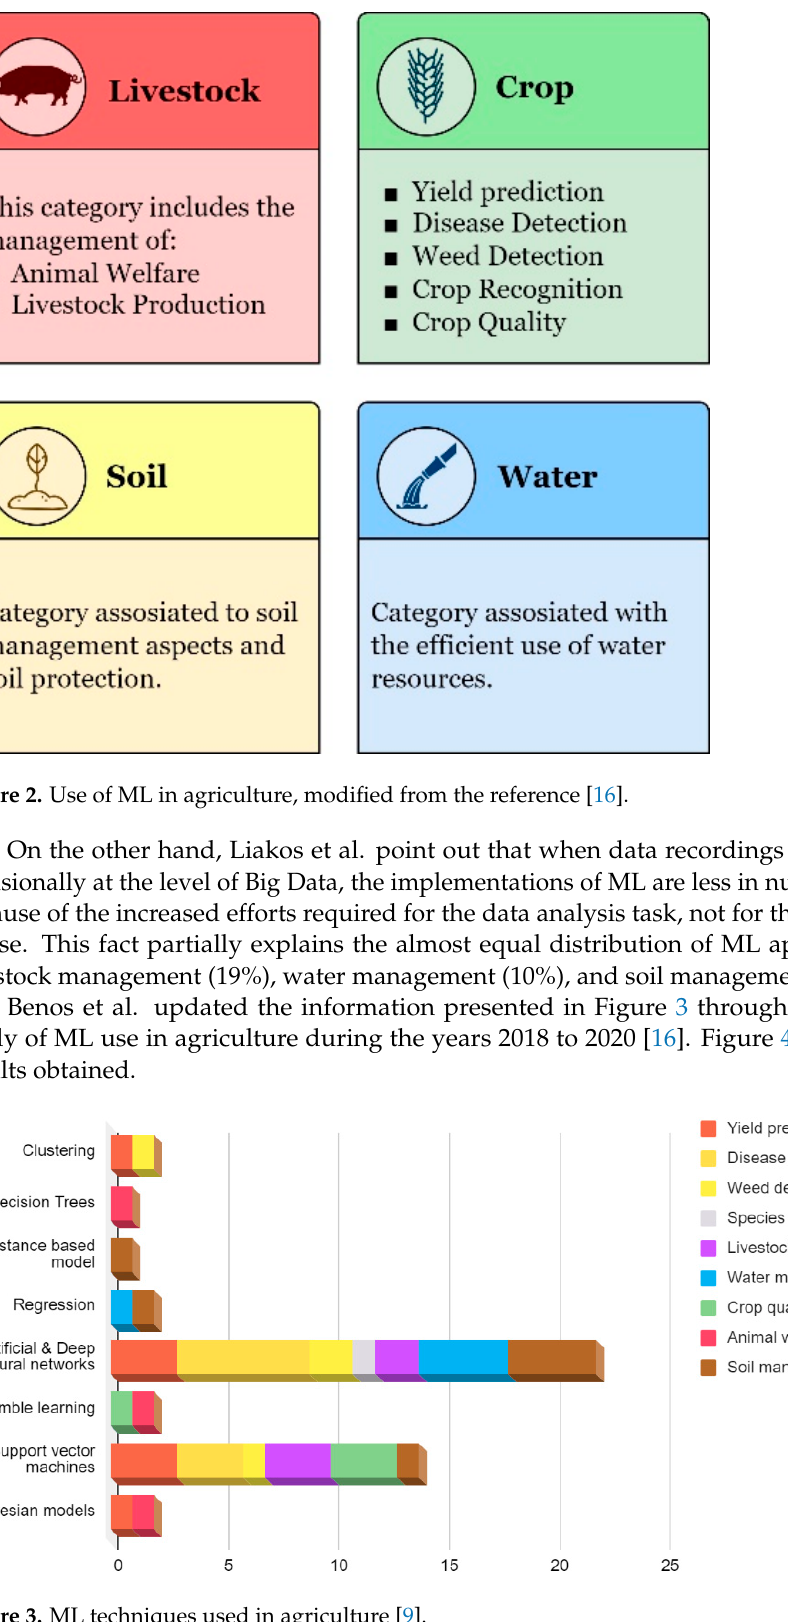
Figure 4. ML models giving the best output [16]. It is observed that the ML ANN algorithm is still the preferred algorithm for data analysis. On the other hand, Ensemble learning has been gaining ground and outperforms other algorithms such as SVM and decision trees (DS). According to Benos et al., the most commonly used data come from meteorology, soil, water and crop quality, remote sens- ing, satellite imagery, UAVs and UAVs, and in situ and laboratory measurements [16]. The most frequent ML model providing the best output was, by far, ANN, which ap- peared in almost half of the reviewed studies (51.8%). RNN followed, representing ap- proximately 10% of ANNs, with long short-term memory standing out, as it can optimize it. The second most accurate ML model was ensemble learning (EL), contributing to the ML models used in agricultural systems with approximately 22.2%, and regression mod- els came next with an equal percentage, namely 4.7%. Both of these ML models were pre- sented in all generic categories. Benos et al. conclude that the increasing interest in ML analyses in agricultural ap- plications is captured. When comparing the number of relevant studies, between 2018 and 2019, there was an increase of 26%. For 2020, the corresponding increase jumped to 109%